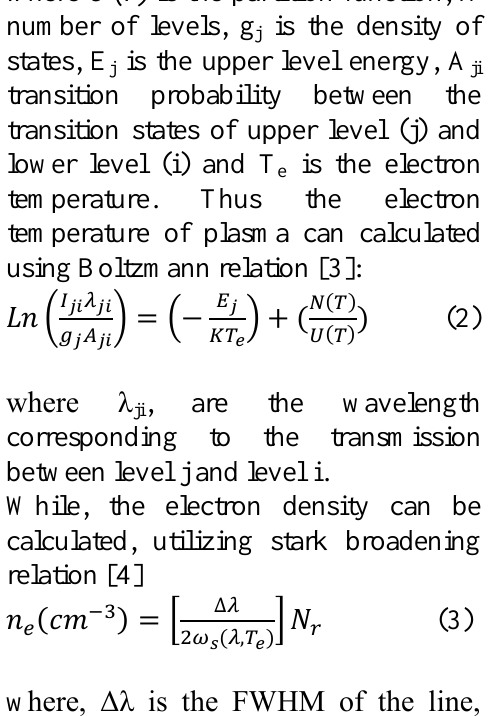
diametr (0.18, 0.24 and 0.3 mm) and 20 mm long is used to produce nano copper particles in volume of 100 ml distilled water. The emitted spectrum produced by the exploding wire was carried by optical fiber to be analyzed using a spectrometer connected with a computer to record the spectra, which then used to study the effect of wire diameter on the properties of the produced